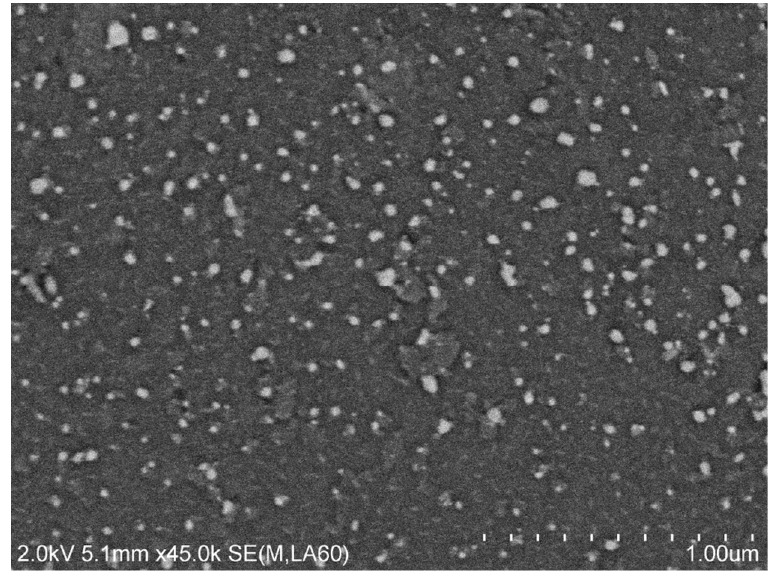
Figure 5. SEM image of sample #3 (concentration 200 mg/L, frequency 3 MHz).